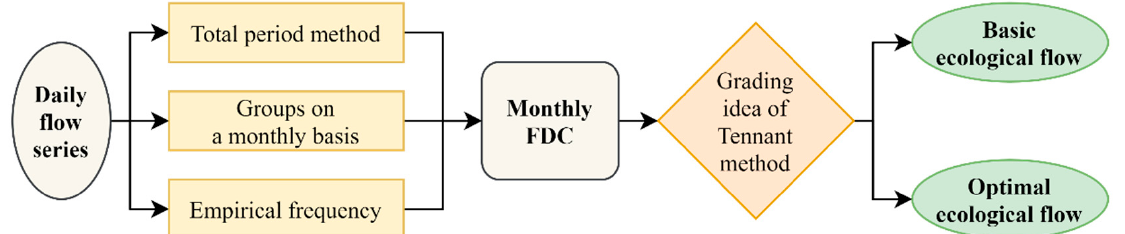
Figure 2. Technical route of the T-FDC method.